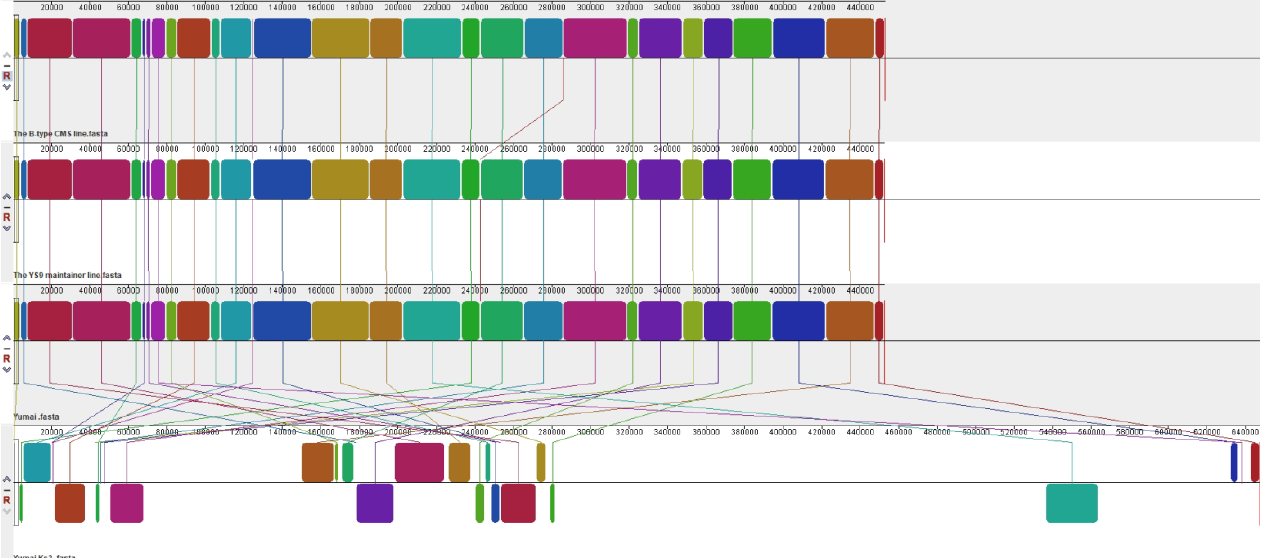
Figure 6. Mauve linear comparison of four mitogenomes: the B-type CMS line and its YS9 main- tainer line, and Yumai Ks3 and Yumai (the K-type CMS line and its maintainer line).